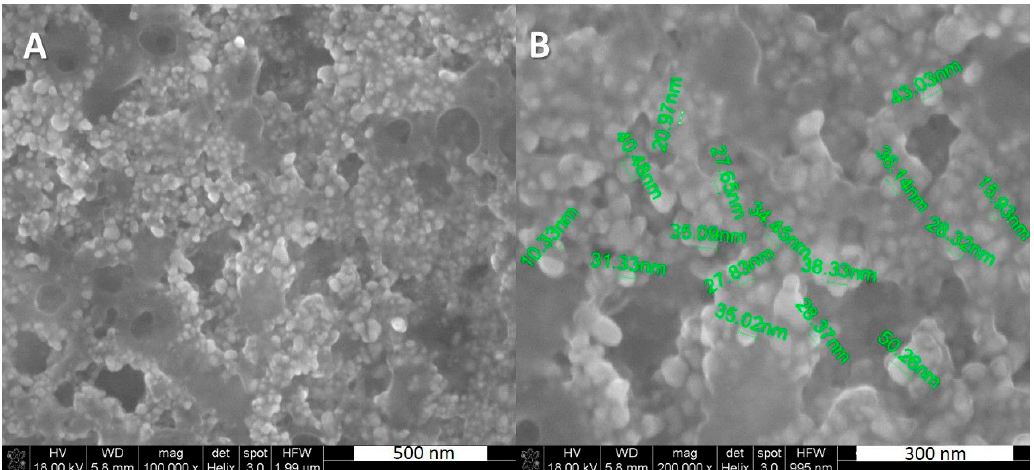
Figure 1. SEM images showing the silver nanoparticles, ( A ) silver nanoparticles (AgNPs), scale 500 nm, ( B ) AgNPs with visible diameter, scale 300 nm.